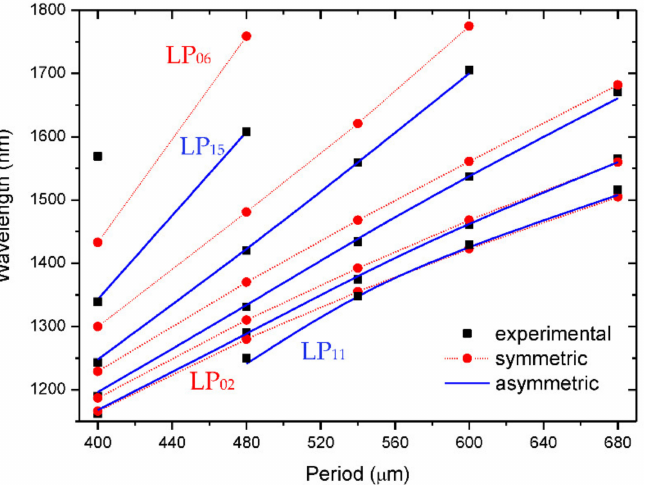
Figure 17. Dispersion curves for symmetric and asymmetric cladding modes. Adapted from